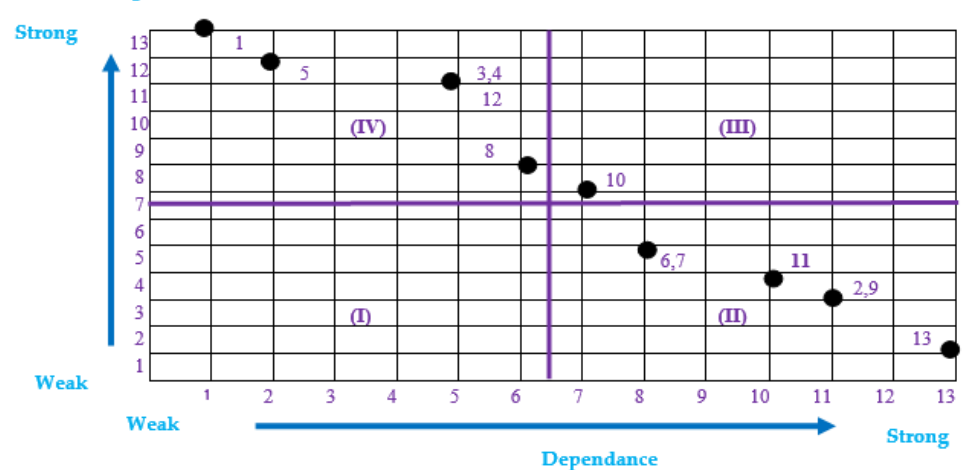
Figure 2. ISM for LBs.